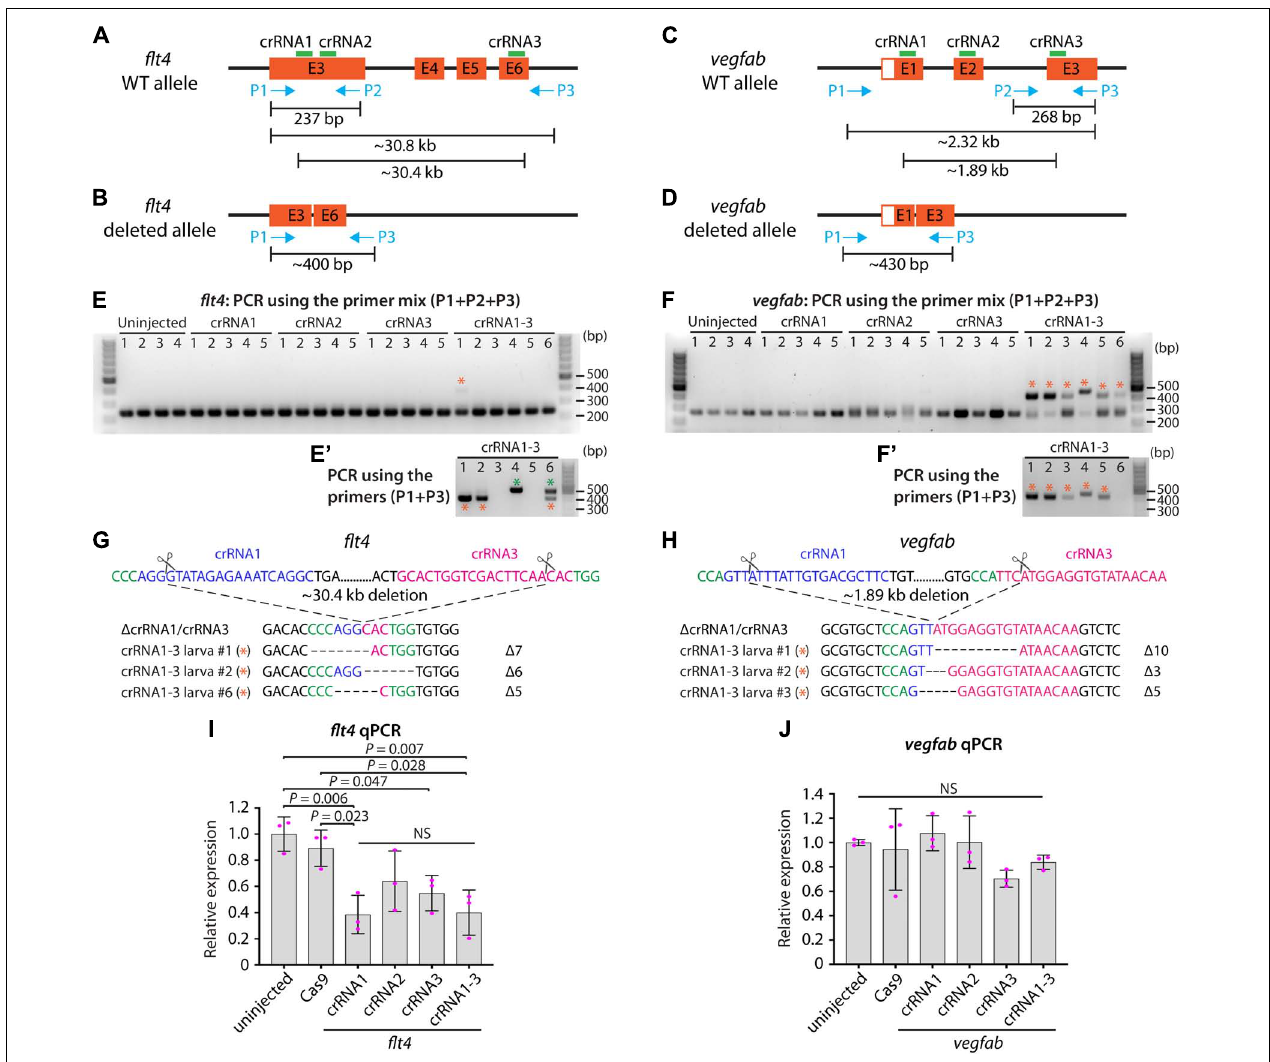
FIGURE 6 | Analysis of large genomic deletions and mRNA decay following cytoplasmic dgRNP injections. (A) Diagram of part of the flt4 genomic locus, indicating approximate locations of the three crRNA target sites and PCR primers. Primer 1 (P1) and primer 2 (P2) were designed to amplify a 237 bp genomic fragment of WT alleles. Primer 3 (P3) was designed far from P1 so these primer pairs cannot efficiently amplify a large genomic fragment ( ∼ 30.8 kb) without undergoing genomic deletions ( ∼ 30.4 kb) induced by crRNA1 and crRNA3. (B) Diagram of the same part of the flt4 genomic locus after the anticipated genomic deletion ( ∼ 30.4 kb) induced by simultaneous targeting of crRNA1 and crRNA3. This genomic deletion is expected to enable PCR amplification of approximately 400 bp of the genomic fragment using primers P1 and P3, which flank these two crRNAs’ target sites. (C) Diagram of part of the vegfab genomic locus, indicating approximate locations of the three crRNA target sites and PCR primers. Primer 2 (P2) and primer 3 (P3) were designed to amplify a 268 bp genomic fragment of WT alleles. Primer 1 (P1) was designed far from P3 so these primer pairs cannot efficiently amplify a large genomic fragment ( ∼ 2.32 kb) without undergoing genomic deletions ( ∼ 1.89 kb) induced by crRNA1 and crRNA3. (D) Diagram of the same part of the vegfab genomic locus after the anticipated genomic deletion ( ∼ 1.89 kb) induced by simultaneous targeting of crRNA1 and crRNA3. This genomic deletion is expected to enable PCR amplification of approximately 430 bp of the genomic fragment using primers P1 and P3, which flank these two crRNAs’ target sites. (E, E’) Genomic DNA from uninjected larvae and those injected with the dgRNPs containing indicated flt4 crRNAs was amplified with the triple primer mix (P1 + P2 + P3; E ). Uninjected larvae and those injected with individual crRNAs displayed only a 237 bp WT genomic fragment band. However, the WT band and an additional amplicon (asterisks) expected to be generated from genomic deletion alleles were both detected in the genomes of some F0 larvae injected with the triple dgRNPs. The additional amplicons were detected in more efficient manner with PCR using only the primer pairs (P1 + P3; E’ ). The bands marked by orange asterisks were detected at the approximate size of 400 bp, whereas those marked by green asterisks were observed at around 500 bp. These bands were cut out and sequenced. (F,F’) Genomic DNA from uninjected larvae and those injected with the dgRNPs containing indicated vegfab crRNAs was amplified with the triple primer mix (P1 + P2 + P3; F ). Uninjected larvae and those injected with individual crRNAs displayed only a 268 bp WT genomic fragment band. However, the WT band and an additional amplicon (asterisks) expected to be generated from genomic deletion alleles were both detected in the genomes of all F0 larvae injected with the triple dgRNPs. The additional amplicons were detected at the approximate size of 430 bp with PCR using only the primer pairs (P1 + P3; F’ ). These bands were cut out and sequenced. (G) Sequence analysis of the PCR products indicated by orange asterisks in (E’) from the triple flt4 dgRNP-injected larvae. The sequence indicated by (cid:49) crRNA1/crRNA3 represents expected perfect end joining after simultaneous flt4 crRNA1 and crRNA3 gene targeting. The number of base pairs that were apparently deleted from this perfect end joining of predicted cleavage sites is indicated. crRNA1 and